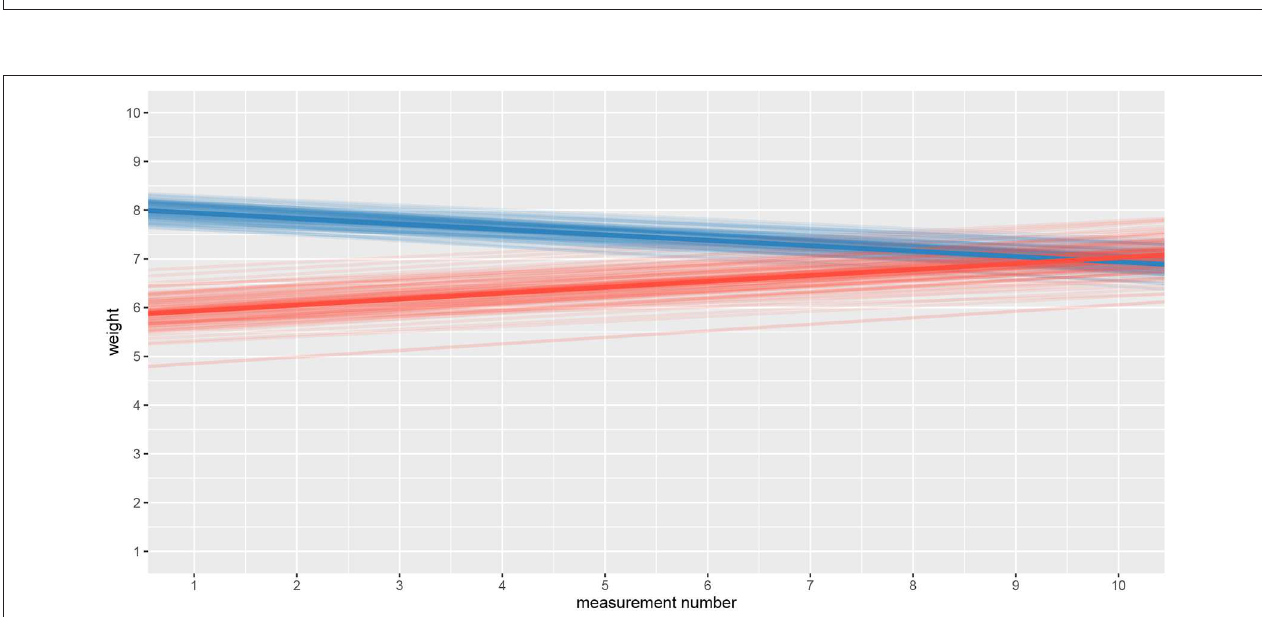
FIGURE 11 | The difference between the intercept of the two fits. Since the entire 95% HDI is positive we are confident that the subject’s that weighted lighter object in the first part of the experiment ( fit1 ) find medium objects heavier than subjects that initially weighted heavier objects ( fit2 ).